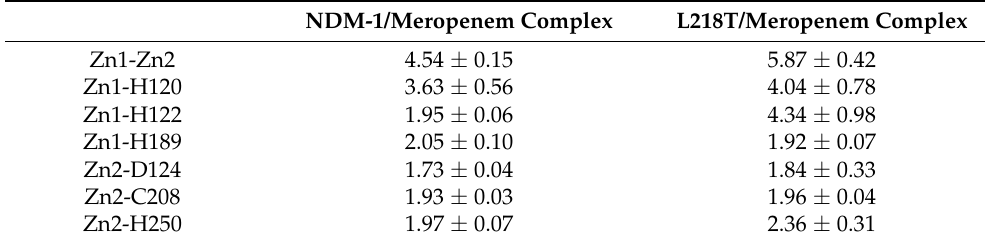
Table 5. Average distances (Å) between Zn and their coordinating atoms, collected from the trajectory of NDM-1 and L218T mutant complexes.